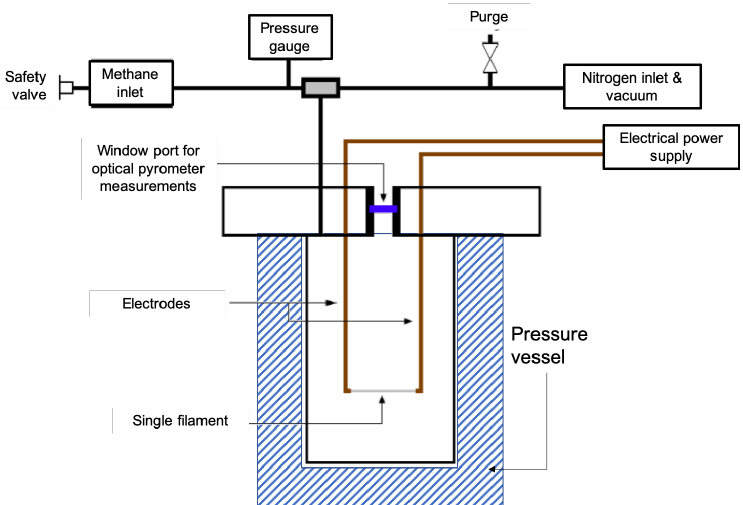
Figure 2. Scheme of the setup for the determination of reaction kinetics on a single